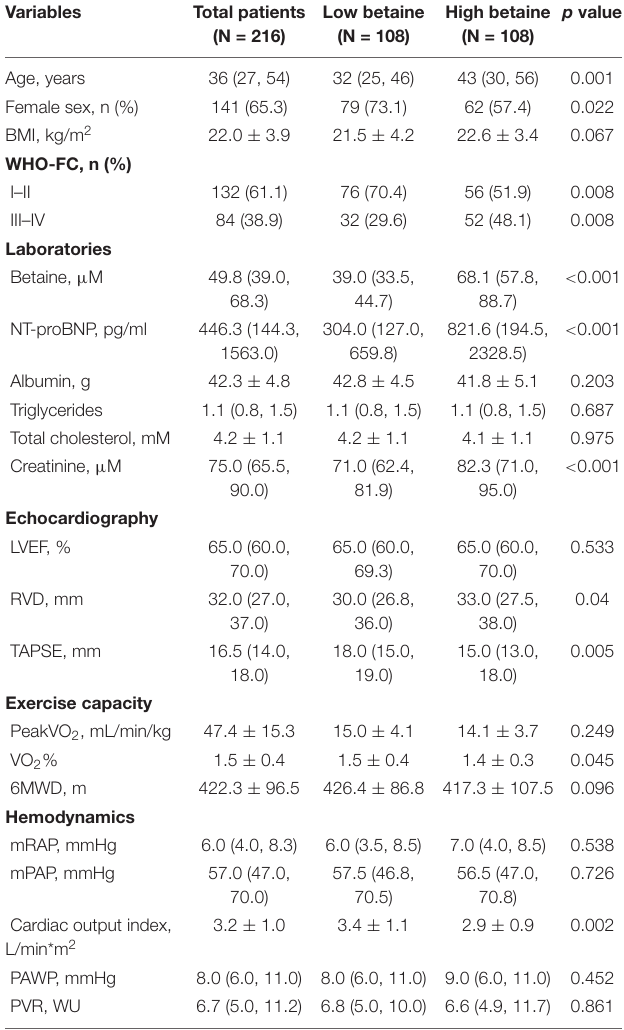
TABLE 1 | Characteristics of patients stratified by 50th percentile of